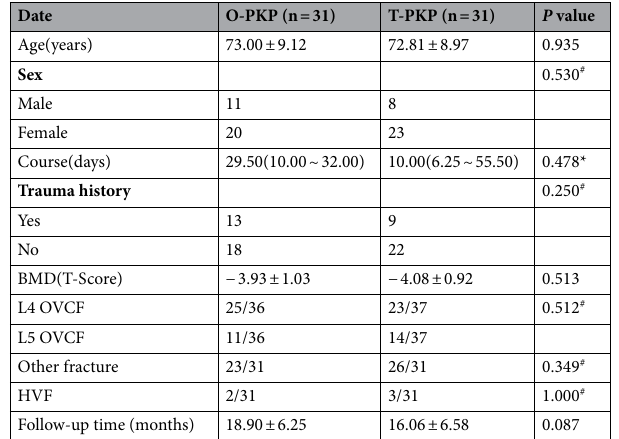
Table 1. Comparison of patient baseline data between two groups. O-PKP, PKP via the entry point “O”; T-PKP, PKP via transverse process-pedicle approach; BMD, bone mineral density; HVF, Historic vertebral fracture. # Data were analyzed by Chi-square test. *Data were analyzed by Friedman rank sum tests and data were expressed as medians (IQR).